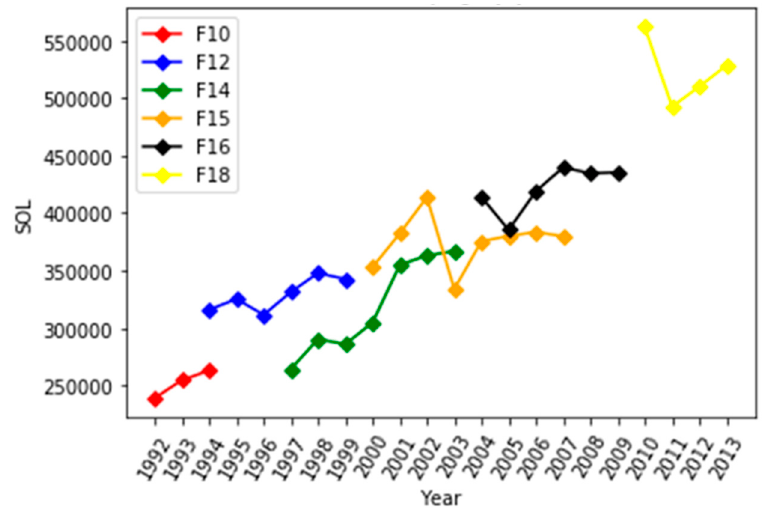
Figure 5. Sum of light (SOL) of DMSP annual composites in Beijing in 1992–2013.